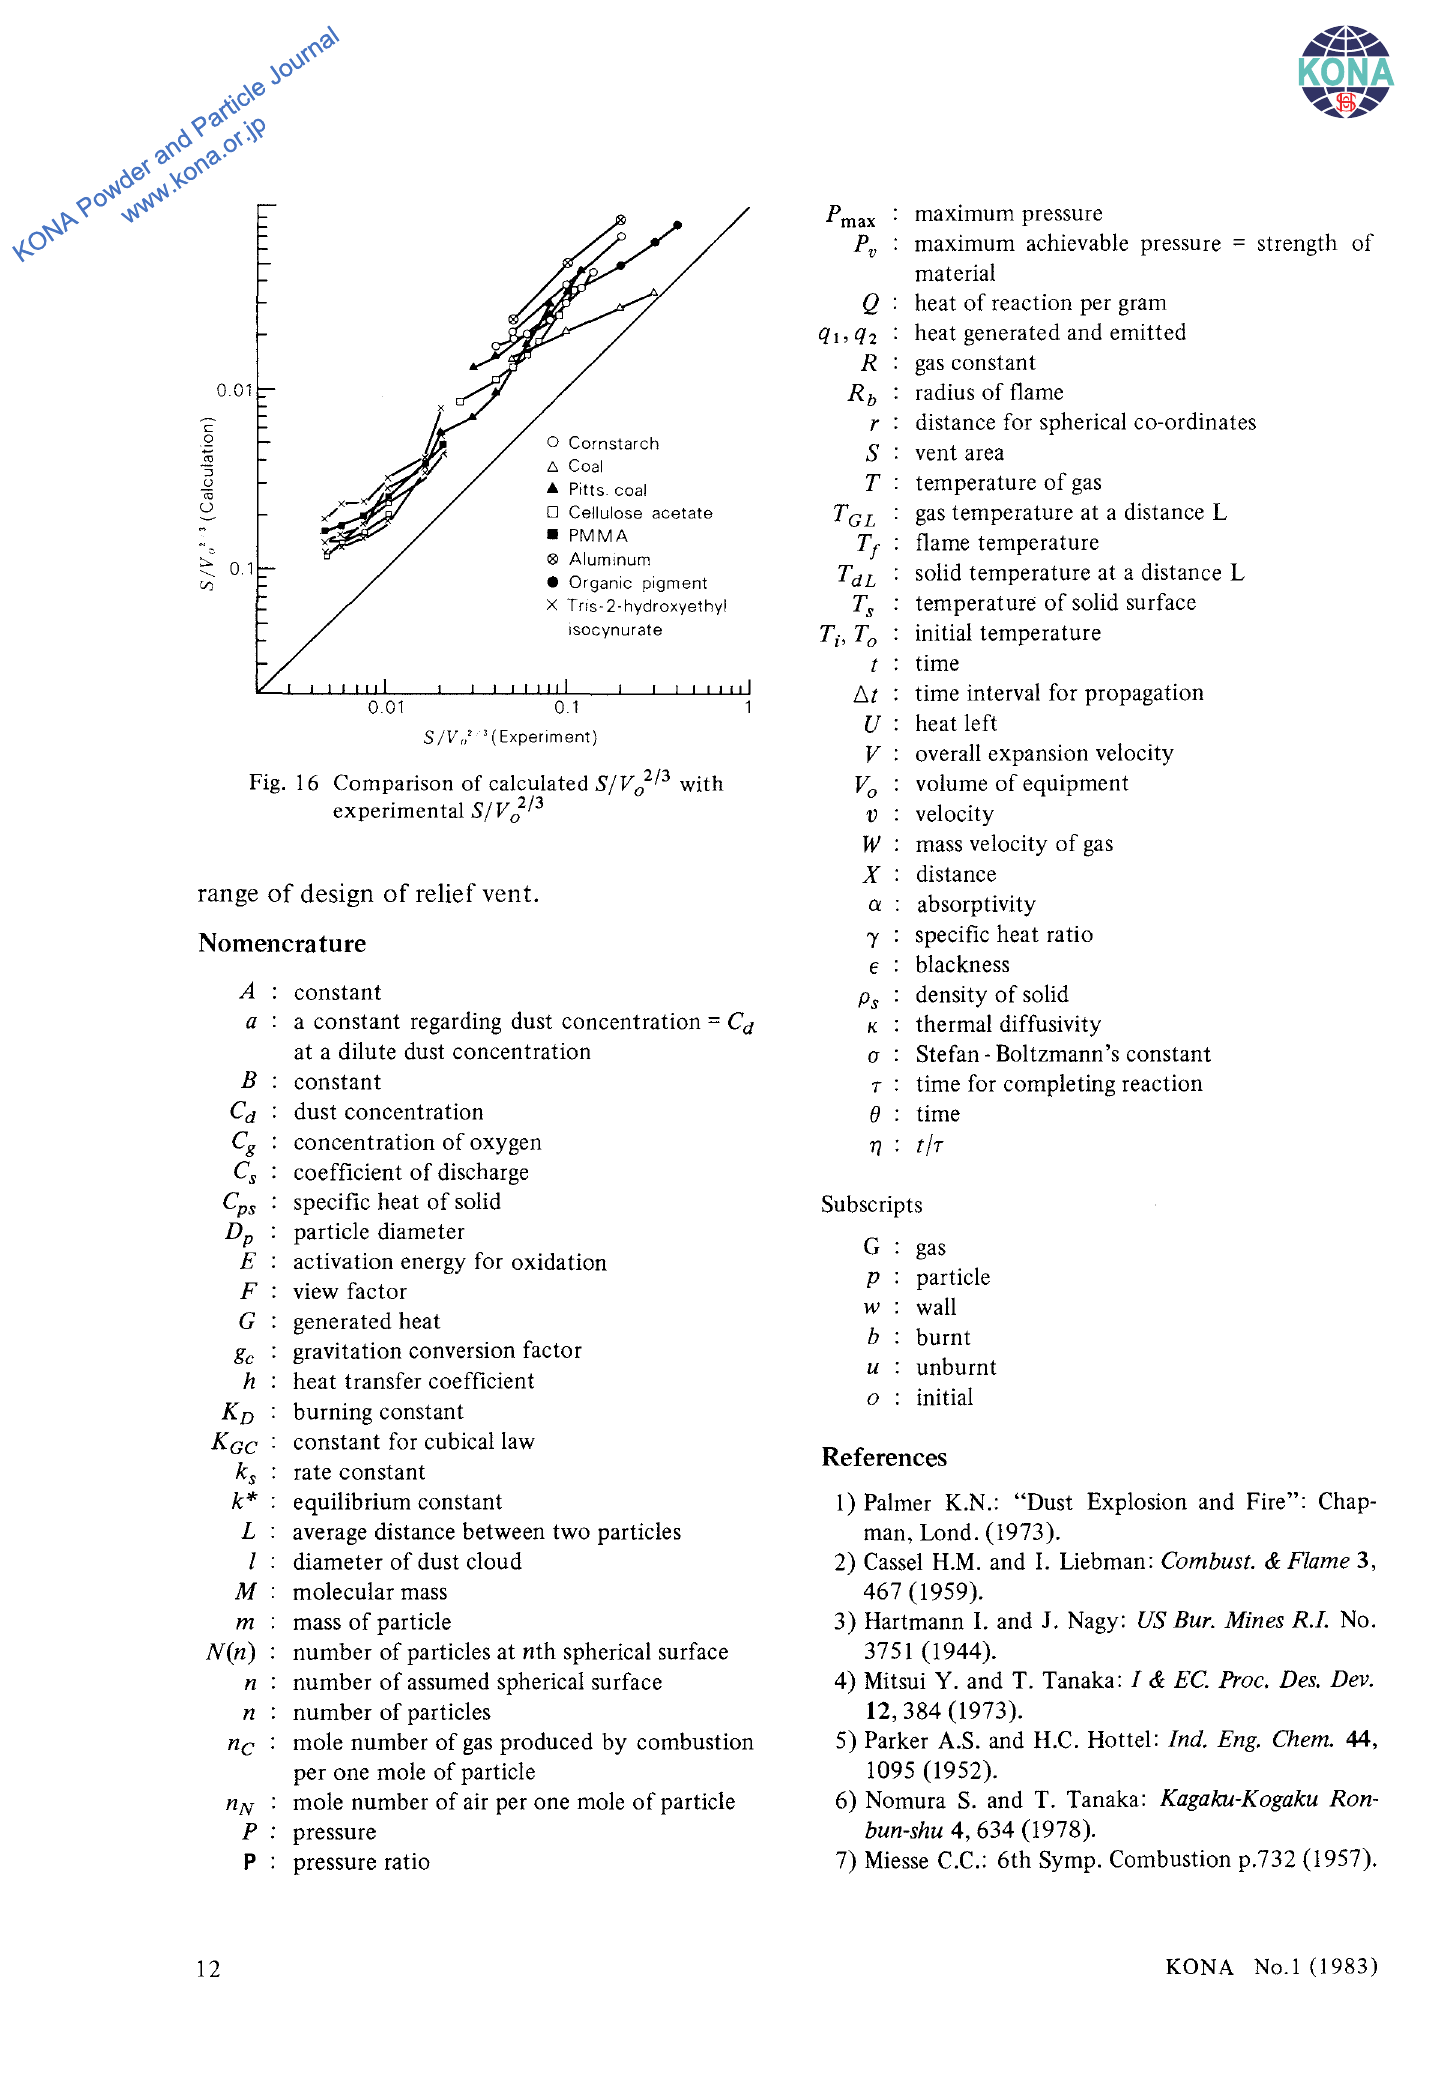
Fig. 16 Comparison of calculated S/V experimental s;v}l 3 range of design of relief